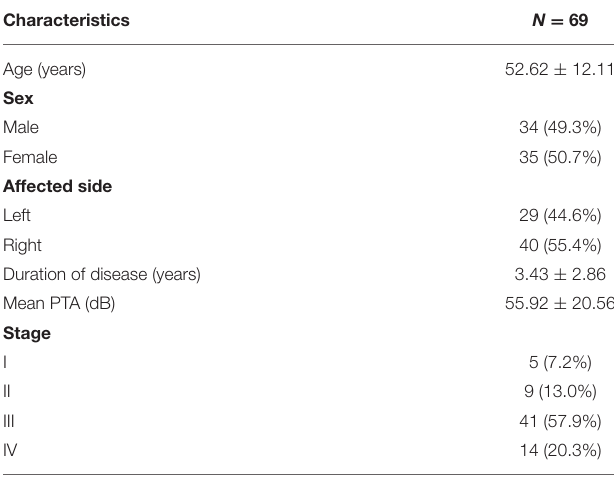
TABLE 1 | Characteristics of the study population.